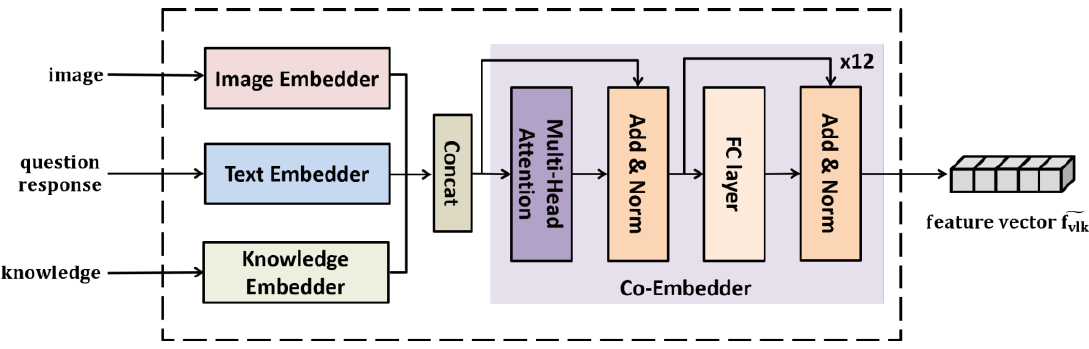
Figure 4. Vision–Language–Knowledge embedding module (VLKEM).